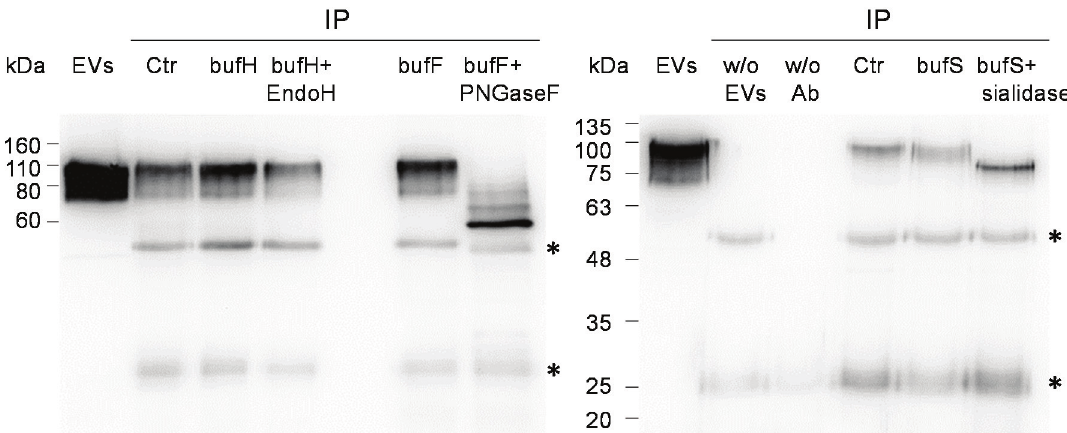
Figure 3. Deglycosylation of immunoprecipitated LGALS3BP. LGALS3BP was